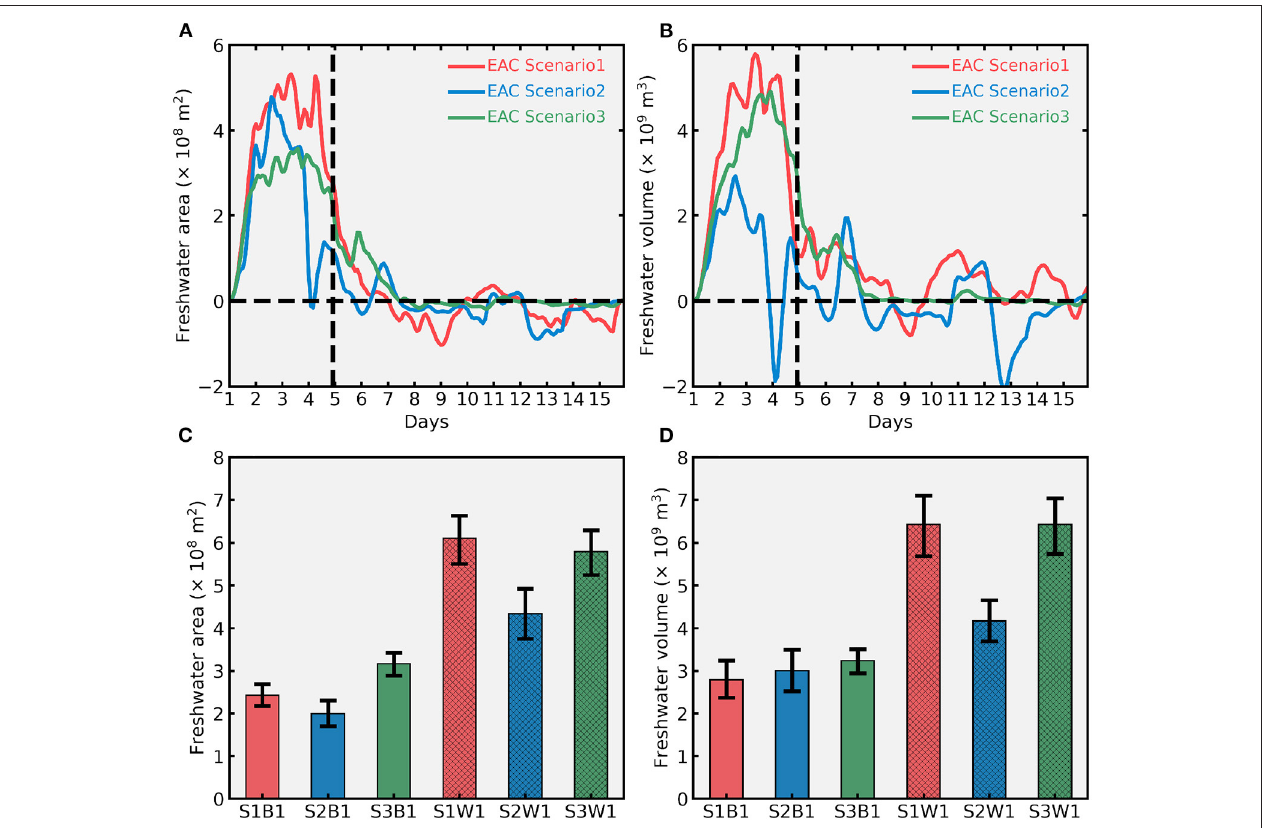
FIGURE 9 | Time series of freshwater area and volume difference between the base case and wet event for each EAC scenario during the whole simulation period. (A) Time series of freshwater area. The solid (dashed) red, blue, and green lines indicate EAC scenario 1, EAC scenario 2, and EAC scenario 3 in the base case (wet event), respectively. (B) Same as (A) , but for the freshwater volume. (C) Freshwater area averaged within the first 4 days for the base case (unhatched bars) and wet event (hatched bars). The red, blue, and green bars indicate EAC scenario 1, EAC scenario 2, EAC scenario 3, respectively. (D) Same as (C) , but for the freshwater